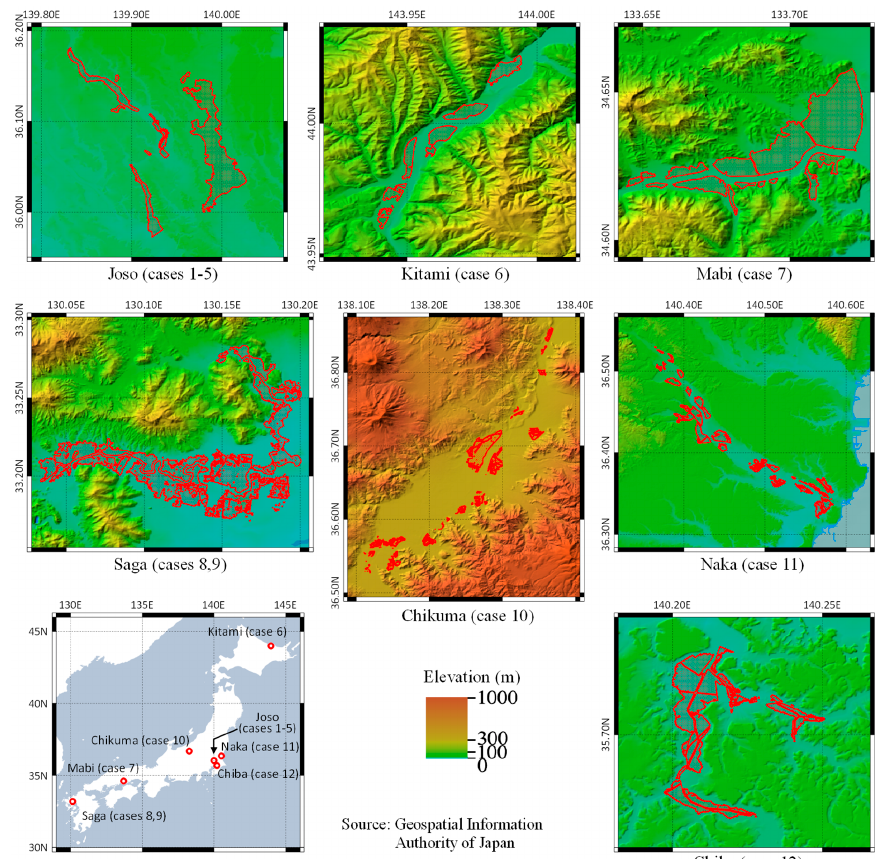
Figure 1. The seven flood-event locations examined in this study. Red polygons show the reference flood maps available from GSI, while the base map shows the elevation